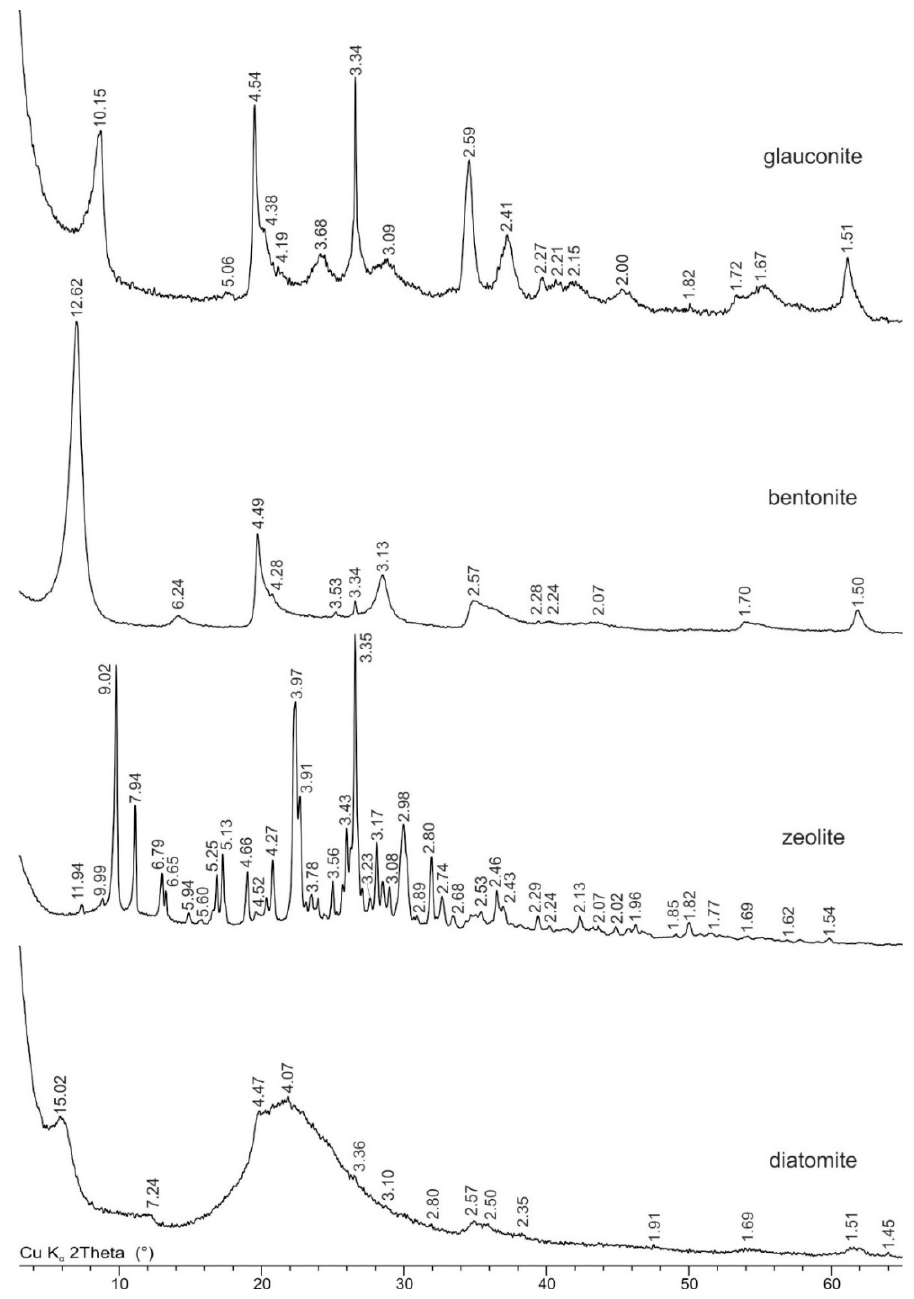
Figure 1. Powder X-Ray di ff raction patterns of natural sorbents. D-spacings are given in angstroms. Figure 1. Powder X ‐ Ray diffraction patterns of natural sorbents. D ‐ spacings are given in angstroms. The studied sample of glauconite had all the characteristic features of the FTIR spectrum: a main The purified sample of bentonite from the 10 ‐ th Khutor deposits predominantly consisted of − 1 band of Si-O stretching vibrations at 1000 cm ; and in the region of Si-O bending vibrations, there 96.8% Na ‐ montmorillonite (Figure 1.). Impurities were represented by 2.4% of quartz and 0.8% of − 1 is a triplet of bands with the following positions: 495, 458 and 437 cm . In the region of stretching anatase. Montmorillonite was identified by a series of basal (12.62 Å, 6.24 Å, 3.13 Å and 2.07 Å) and − 1 vibrations of ОН groups, there is a wide complex band at 3400–3700 cm , which can be considered as a non ‐ basal (4.49 Å, 2.57 Å, 1.70 Å, and 1, 50 Å) reflections with an indicative broad peak profile. In result of the superposition of individual absorption bands of the cation–OH–cation. There is an intense turn, quartz was identified by significantly sharper peaks at 3.34 Å, 4.28 Å, and 2.28 Å. Finally, + + − 1 band at 3545 cm (which corresponds to the superposition of the absorption bands of Fe 2 –OH–Fe 2 , + + + + + + + Fe 2 –OH–Fe 3 , Fe 3 –OH–Fe 3 , Fe 2 –OH–Mg, Fe 3 –OH–Mg, and Al–OH–Fe 2 ), a recognizable band + − 1 − 1 at 3560 cm (Al–OH–Fe 3 , and Mg–OH–Mg), and a minor band at ~3600 cm (Al–OH–Mg and − 1 several Al–OH–Al bands). In addition to glauconite, trace amounts of impurities of silica (680 cm ) − 1 − 1 and carbonates (1404 cm and 870 cm ) were